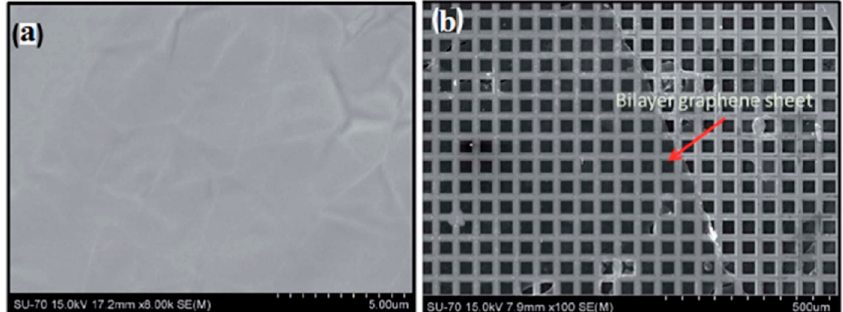
Figure 27. ( a ) FESEM image of the as-grown graphene films on Cu; ( b ) high-magnification FESEM image of a bilayer graphene sheet on a Cu grid, prepared by hot filament thermal CVD (reprinted with permission from [193]).